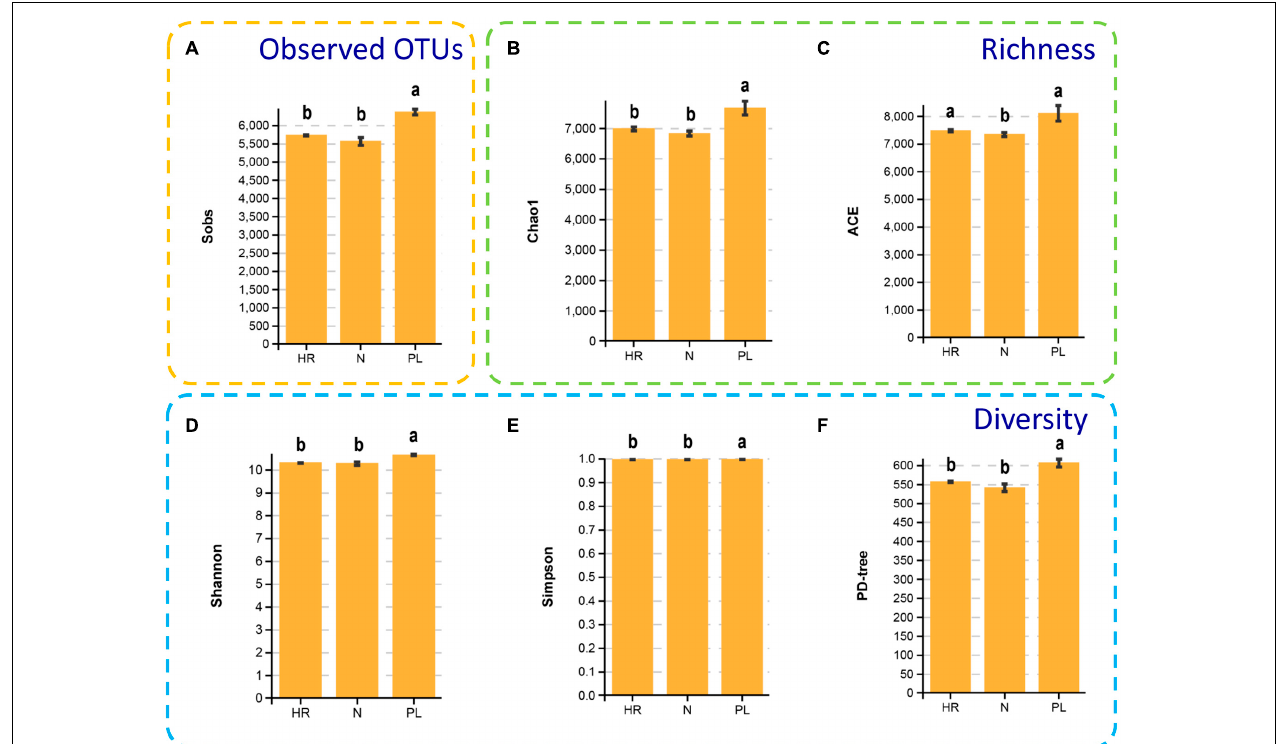
FIGURE 4 | Alpha diversity of the microbial communities of the rhizospheric bacterial communities of the N, HR, and PL field samples. Sobs (A) , Chao1 (B) , ACE (C) , Shannon (D) , Simpson (E) , and PD-tree (F) . Different letters indicate significant differences (Tukey-HSD, p < 0.05). N, soil from the C. yanhusuo field without rotation; HR, soil from the C. yanhusuo field that had been flooded in July 2020; PL, soil from the field under peanut– C. yanhusuo rotation.